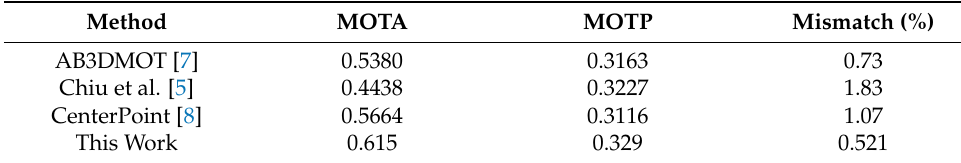
Table 8. Comparison on Waymo Open Dataset test set, pedestrian class.